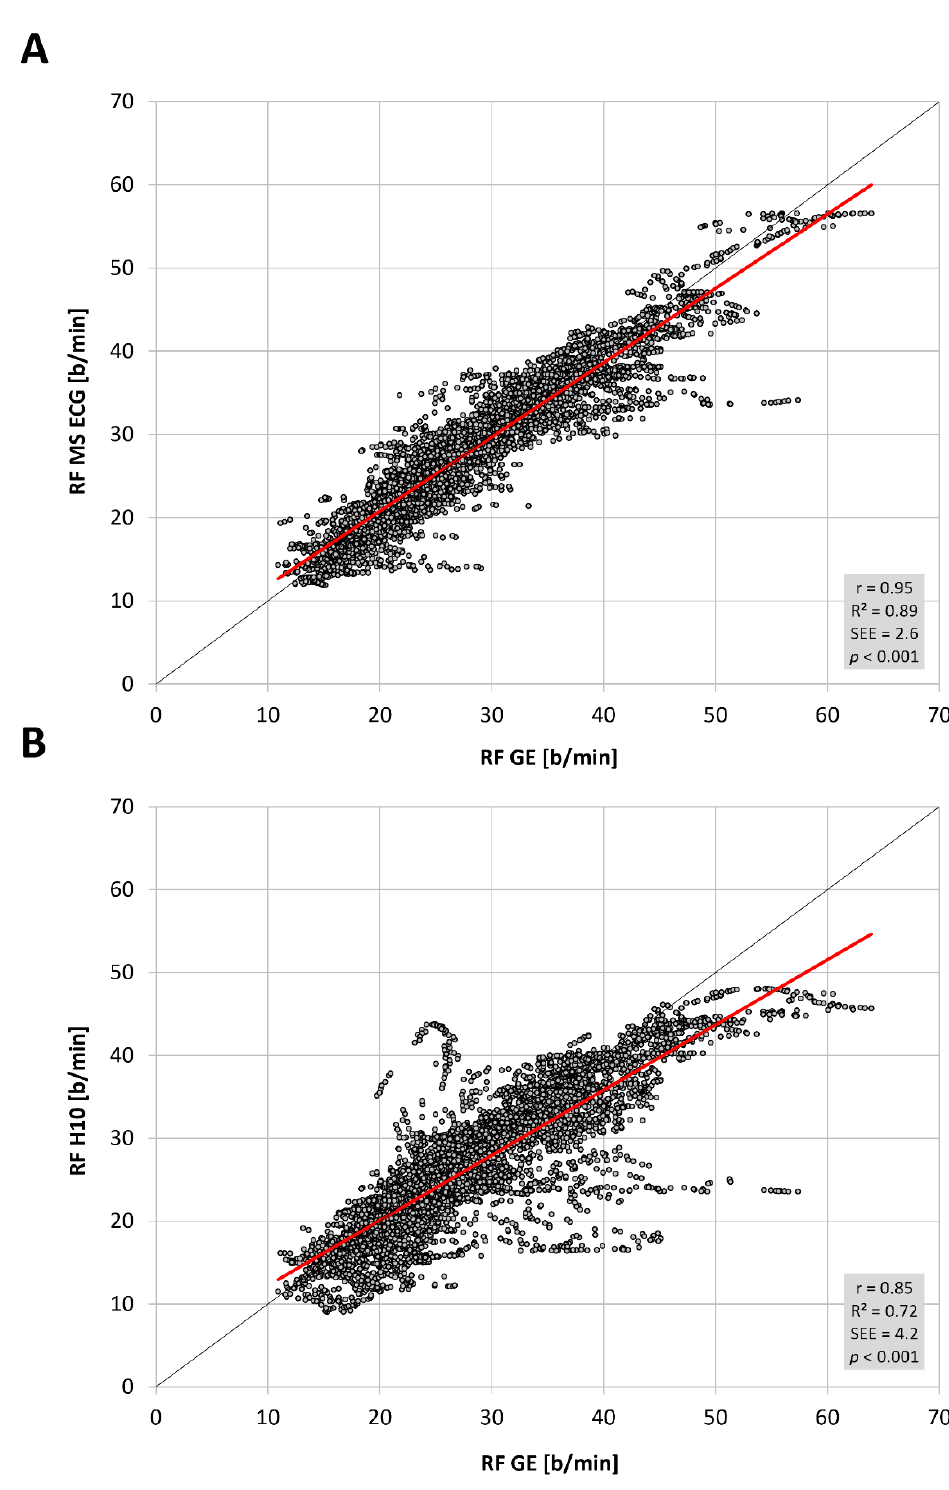
Figure 1. Regression plots for the comparison of respiratory frequency (RF) in breaths/min (b/min) for the ( A ) Movesense Medical sensor ECG (MS ECG) and the ( B ) Polar H10 sensor chest belt device (H10) vs gas exchange data (GE) during the incremental exercise test. Coefficient of determination (R 2 ), Pearson’s r, standard error of estimate (SEE), and p value shown in the bottom right plot. Regression line in red, line of unity shown in dark grey.